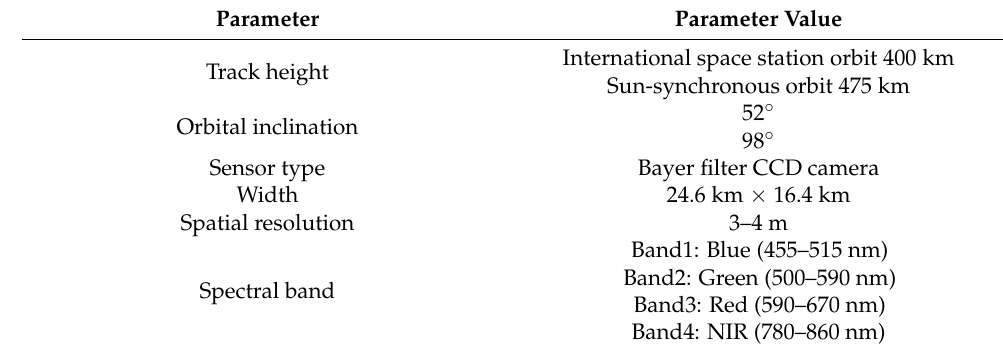
Table 1. Key parameters of the